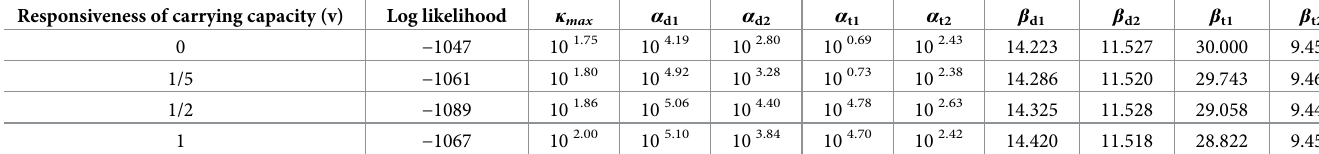
Table 2. Estimated parameter of each model and its fitting to the observations.